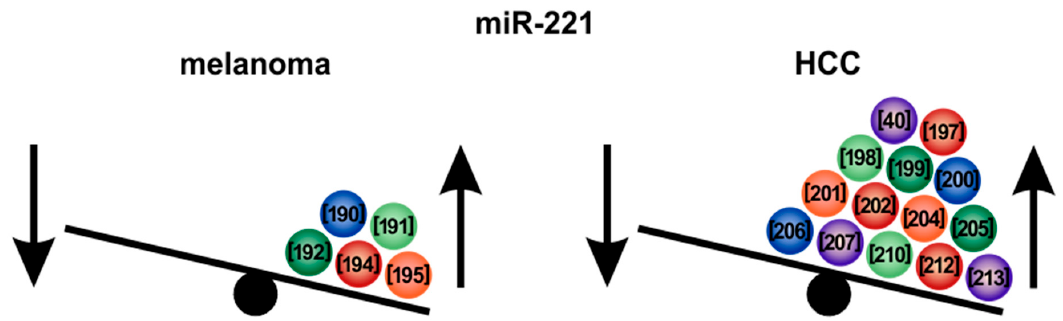
Figure 6. Upregulation of OncomiR miR-221 in melanoma and HCC. References (numbers in brackets indicate according references of studies) showing differential expression (indicated by arrows) of miR-221 in melanoma and HCC.